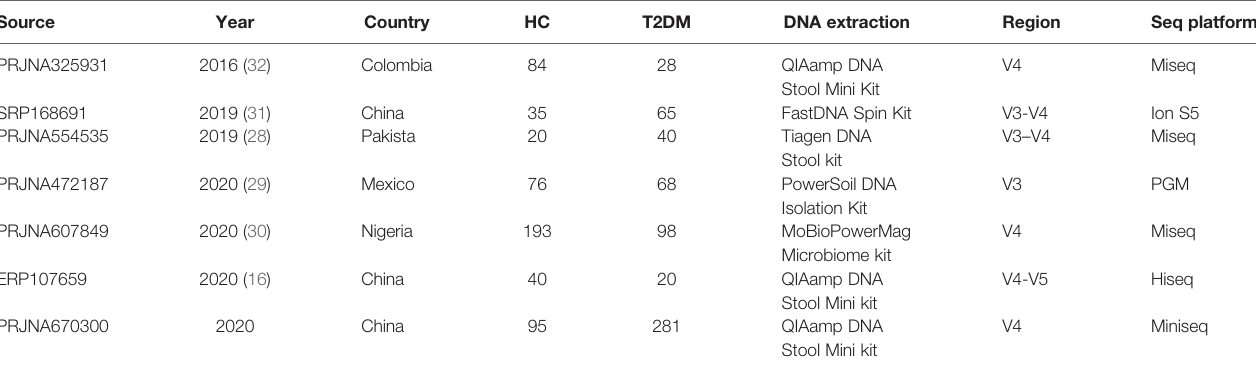
TABLE 1 | Characteristics of the data sets included in the fecal sample-based